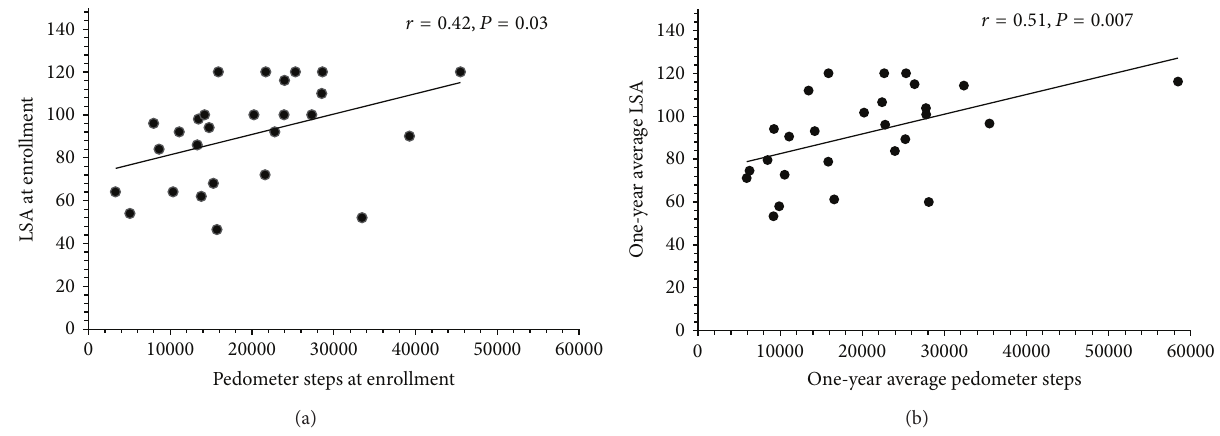
Figure 1: Relationship between Life-Space Assessment score and steps recorded by pedometer at enrollment (a) and over 1 year (b). The Life-Space Assessment score was positively associated with physical activity as assessed by pedometers in adult subjects with cystic fibrosis at enrollment and after 1 year of follow-up.